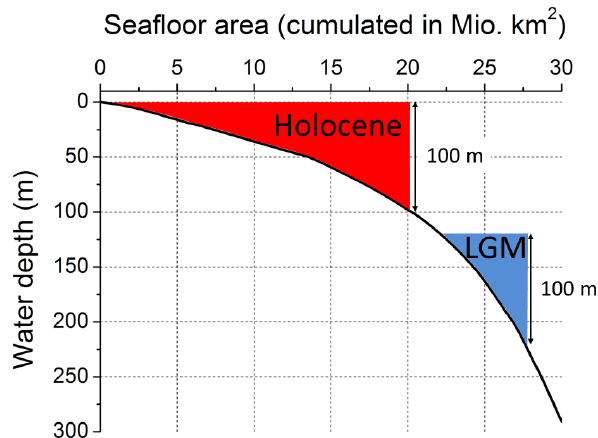
Figure 1. Morphology of global ocean margin. The black line is the cumulated seafloor area as derived from the high-resolution ETOPO 1 grid (Eakins and Sharman, 2012). The ocean margin at 0–100m water depth is indicated for the modern ocean (red area) and for the LGM when eustatic sea-level was lowered by 120m (blue area). The global ocean retreated into steeper terrain during the glacial marine regression. The seafloor areas covered by shallow waters were reduced by this steepening of ocean